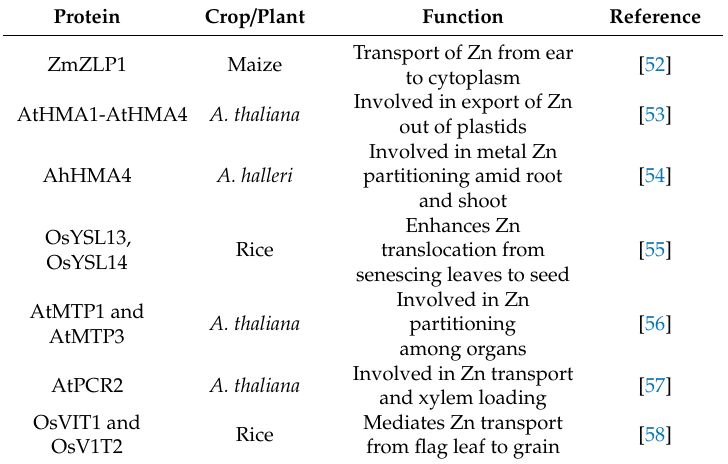
Table 1. Zn transporter proteins in di ff erent